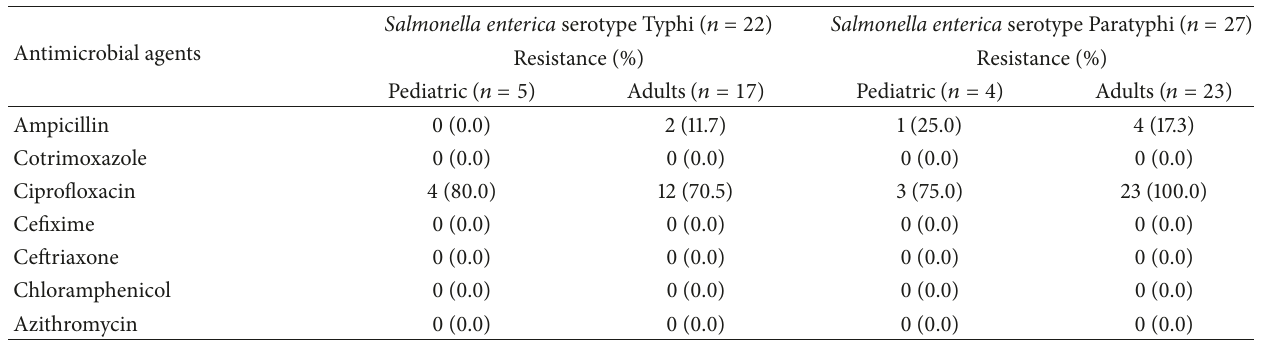
Table 4: Trends of antimicrobial susceptibilities of Salmonella enterica clinical isolates ( 𝑛 = 49 ). Antimicrobial agents